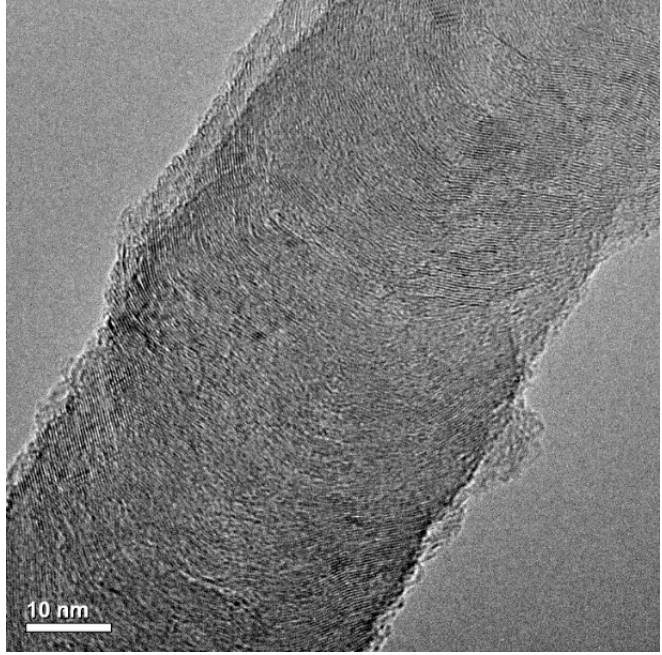
Figure 2. Transmission electron microscope (TEM) image of carbon nanofiber (CNF), a closer nano-structure of an individual fiber .